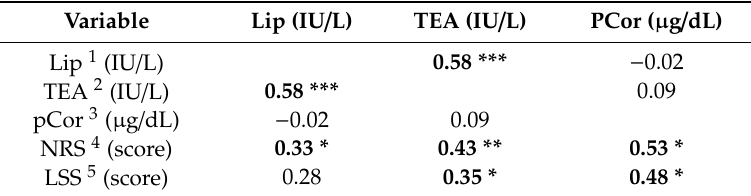
Table 3. Correlation coe ffi cients between Lipase (Lip) and total esterase (TEA) in saliva and plasma cortisol (pCor) concentrations, NRS, and LSS in 22 cows with lameness (n = 11) and healthy cows (n =